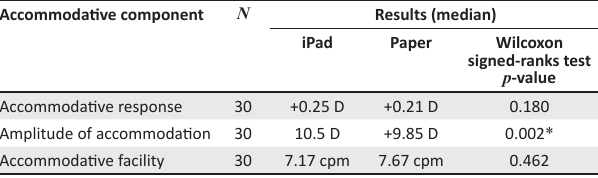
TABLE 1: Summary of medians for the accommodative components assessed. Accommodative